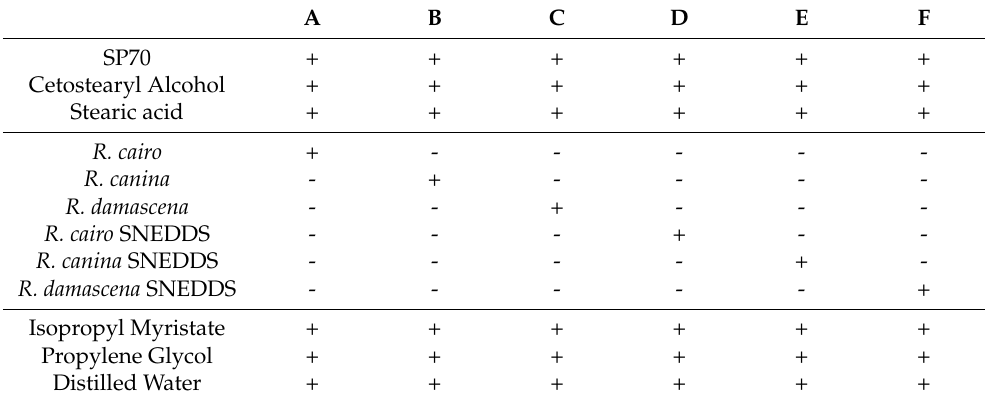
Table 7. Compositions of the formulated ointments containing different rose